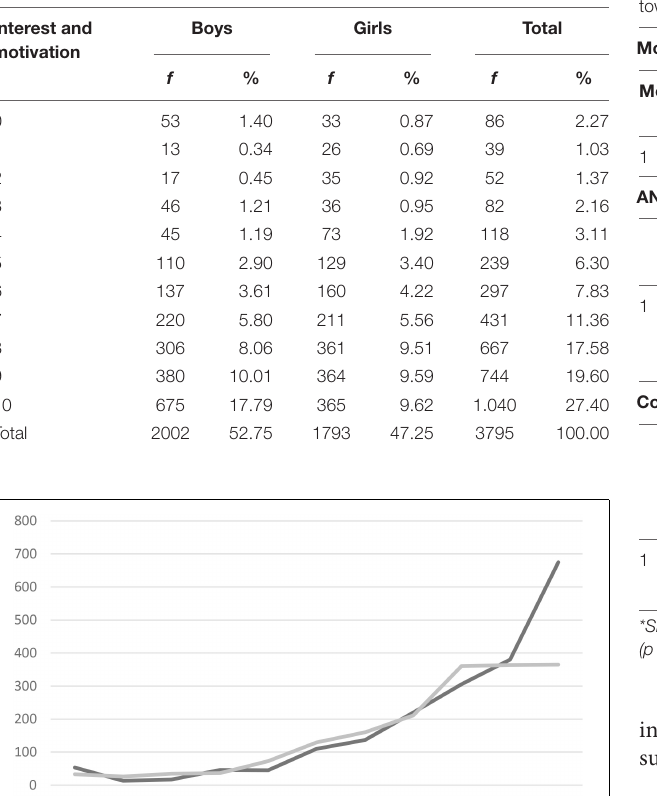
TABLE 7 | Interest and motivation for math by sex.